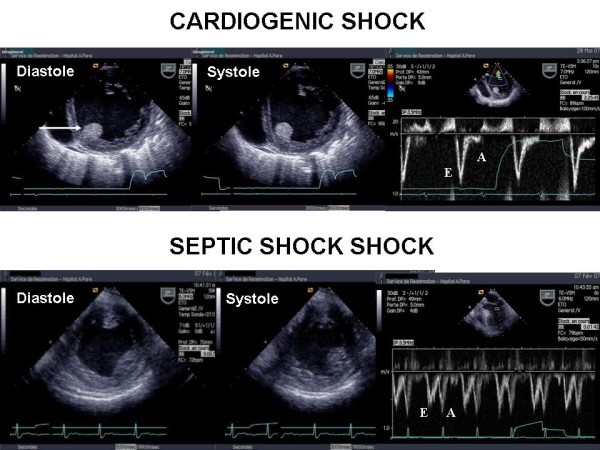
Transesophageal echocardiography in two patients--one with cardiogenic shock (above) and the other with septic shock (below). In the patient with cardiogenic shock, the left ventricular short-axis view demonstrated global hypokinesia of the left ventricle with major dilatation. Pulsed Doppler at the mitral valve demonstrated a restrictive pattern of the left ventricular inflow with a high E wave velocity and a very low A wave velocity, highly suggestive of a high LV filling pressure. Note also the thrombus in the left ventricle (arrow). In the patient with septic shock, the short-axis view also demonstrated global hypokinesia of the left ventricle, but without a major dilatation. Note also the Doppler profile at the mitral valve, highly suggestive of normal LV filling pressure.